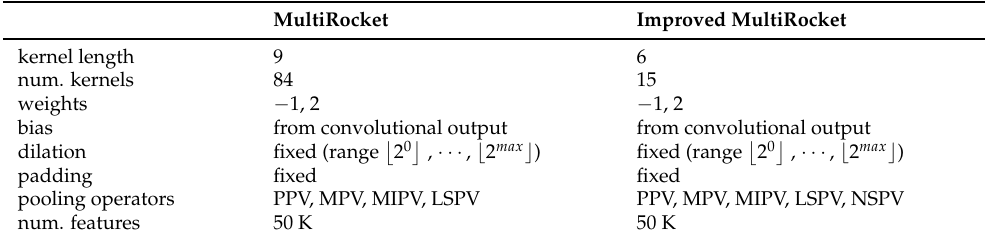
Table 2. Comparison of MultiRocket and improved